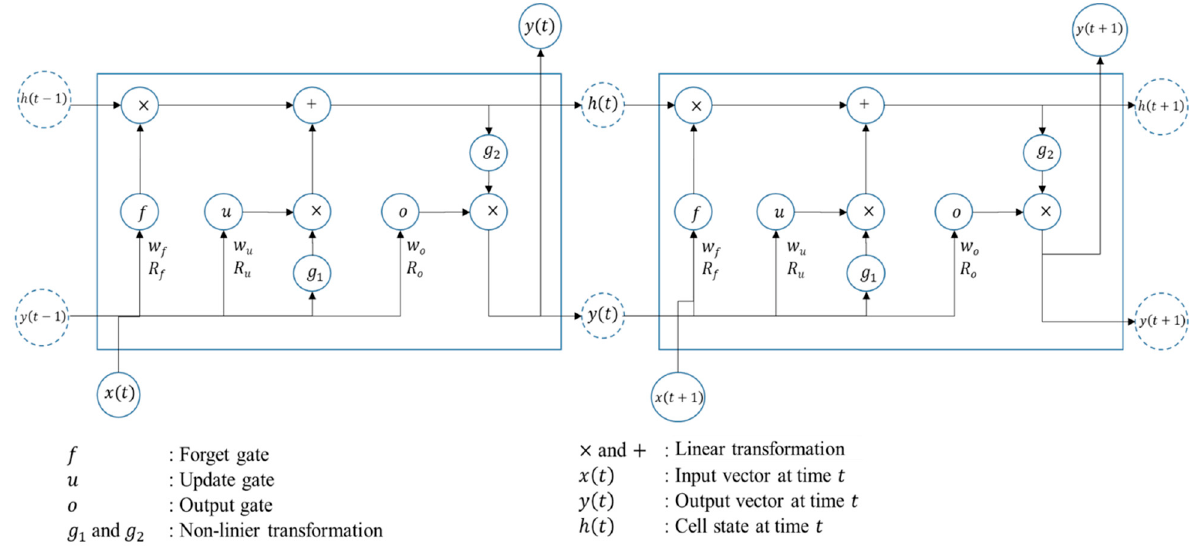
Figure 3. LSTM RNN